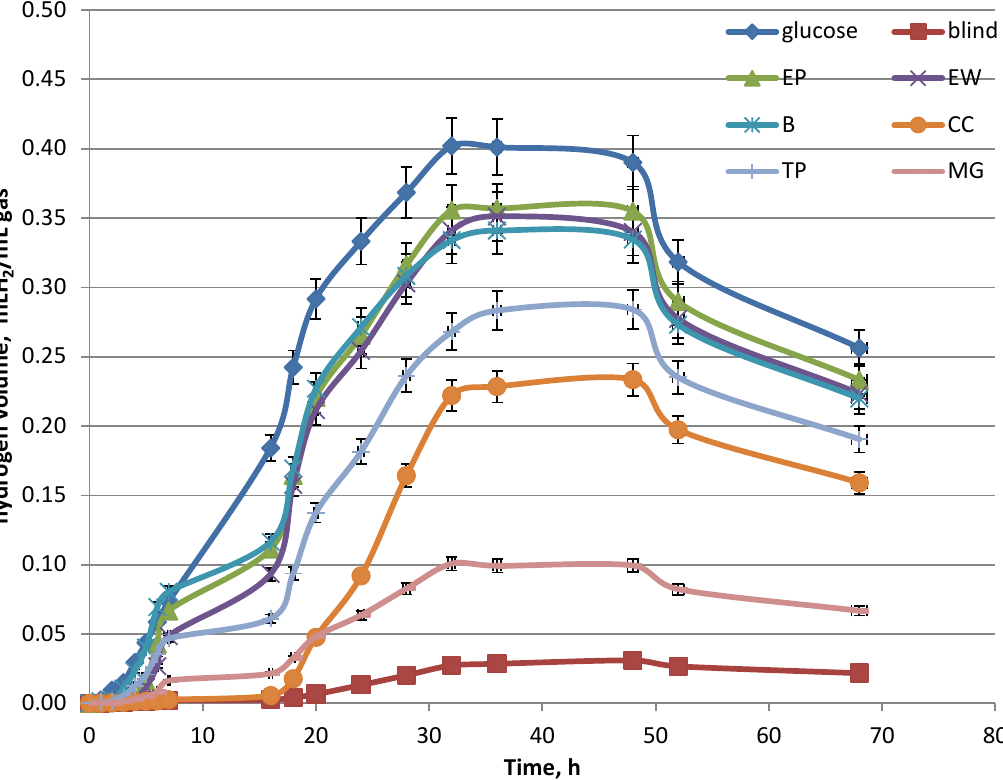
Figure 5. Changes in the volumetric concentration of hydrogen for different feed materials during dark fermentation experiments.